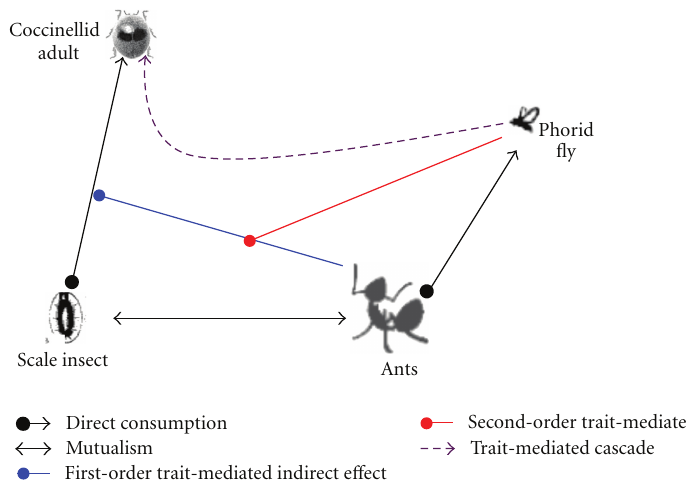
Figure 1: Diagrammatic representation of the cascading trait-mediated indirect interactions between Pseudacteon spp. and Azya orbigera . Arrows represent positive e ff ects and solid circles represent negative e ff ects. Black solid lines represent direct interactions, the blue solid line represents first level trait-mediated indirect interactions, the red solid lines represents the second level trait-mediated indirect interactions, and the dashed purple line represents the resulting cascading trait-mediated indirect interaction between the phorid flies and the coccinellid